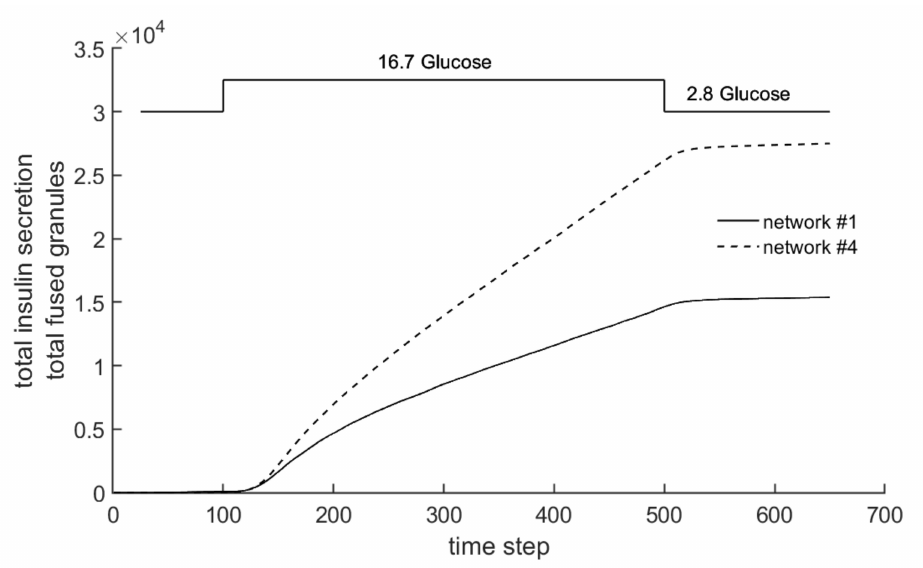
Figure 19. Behavior of insulin secretion of networks #1 and